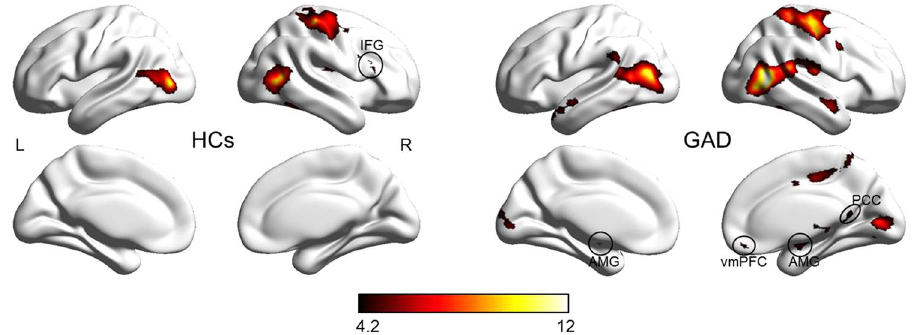
Figure 2. Within-group brain activation for the contrast of negative versus neutral stimuli evaluation in adolescents with GAD and HCs. The threshold was set at p < 0.05, AlphaSim corrected (i.e., p-voxel < 0.0005 with minimum cluster size = 22 voxels). Color bar denotes t value. IFG = inferior frontal gyrus, AMG = amygdala, vmPFC = ventromedial prefrontal cortex, PCC = posterior cingulate cortex, L = left, R = right, GAD = generalized anxiety disorder, and HCs = healthy controls.